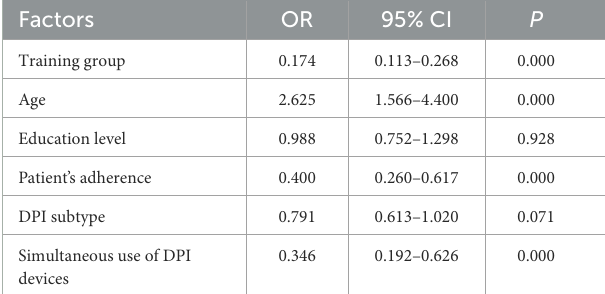
TABLE 6 Logistic regression analysis of key factors influencing inhaler use ability in all subjects ( n = 489).